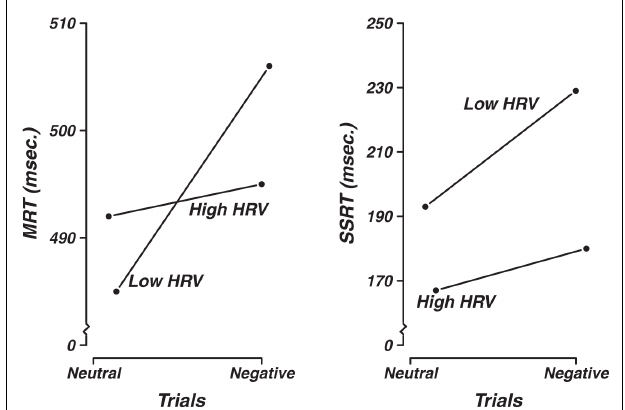
FIGURE 3 |Two 2 × 2 interactions between trial type and group. On the left panel, it is shown that participants needed more time to respond in the negative compared to neutral trials. On the right panel, the time to inhibit a planned response for each trial is depicted. Although participants needed more time to inhibit a response in negative compared to neutral trials, this increase in SSRT’s is quicker for participants with low HRV. Please see text for further details on both interactions. MRT , median response time; SSRT , stop-signal reaction time, HRV , heart rate